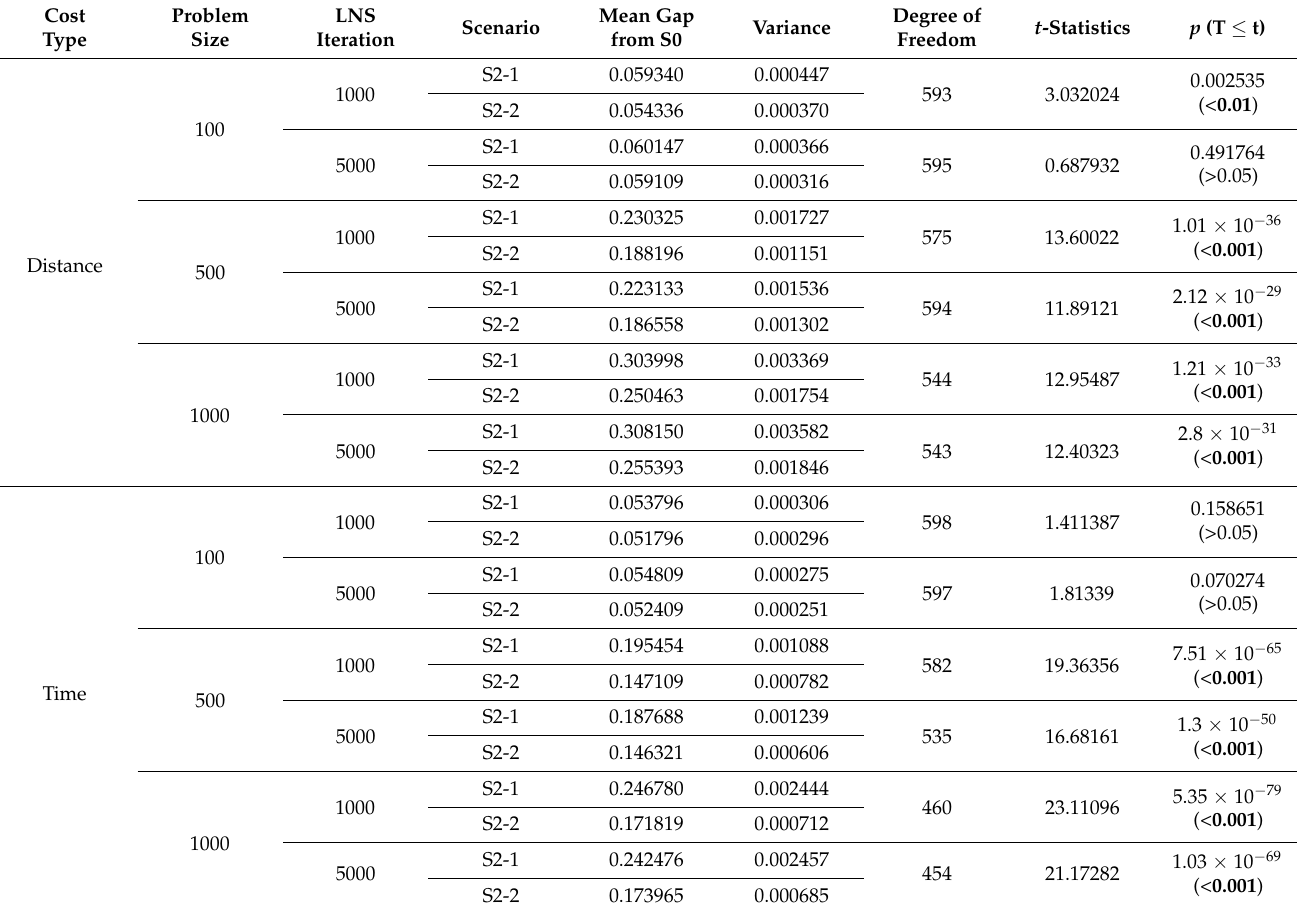
Table 3. t -test to compare the implementation scenario ‘S2-1’ and